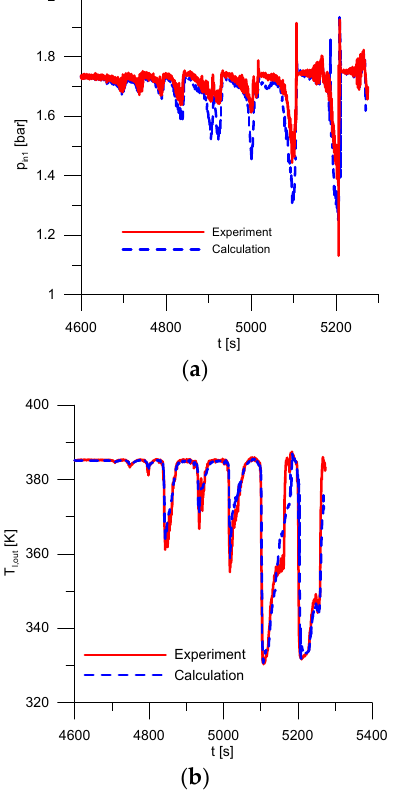
Figure 5. Comparison between calculation and experiment: ( a ) inlet pressure; ( b ) outlet temperature.